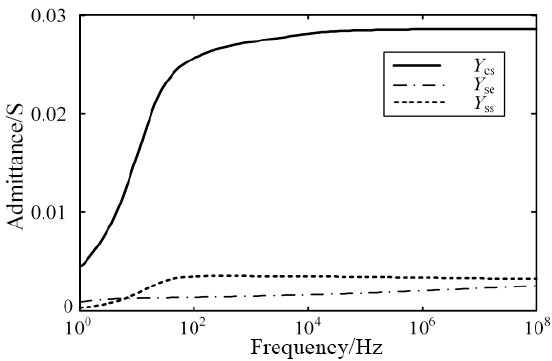
Figure 3. Three-phase cable characteristic admittance model.